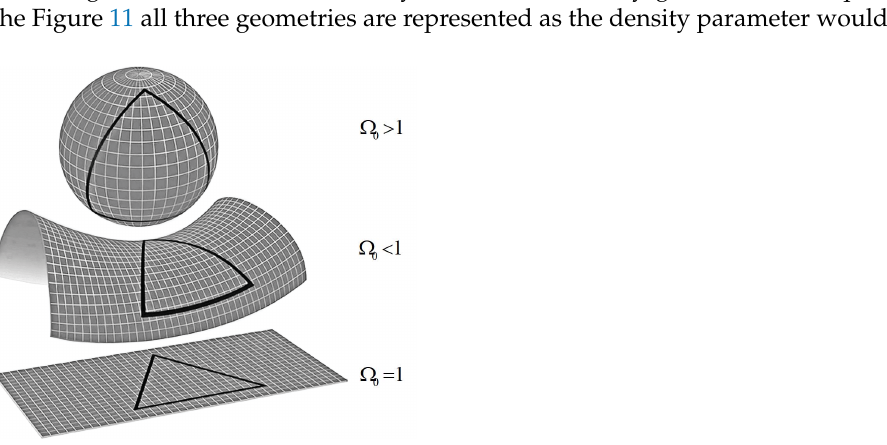
Figure 11. The spherical geometry Ω 0 > 1 and for hyperbolic geometry Ω 0 < 1 and Ω 0 = 1 represents flat